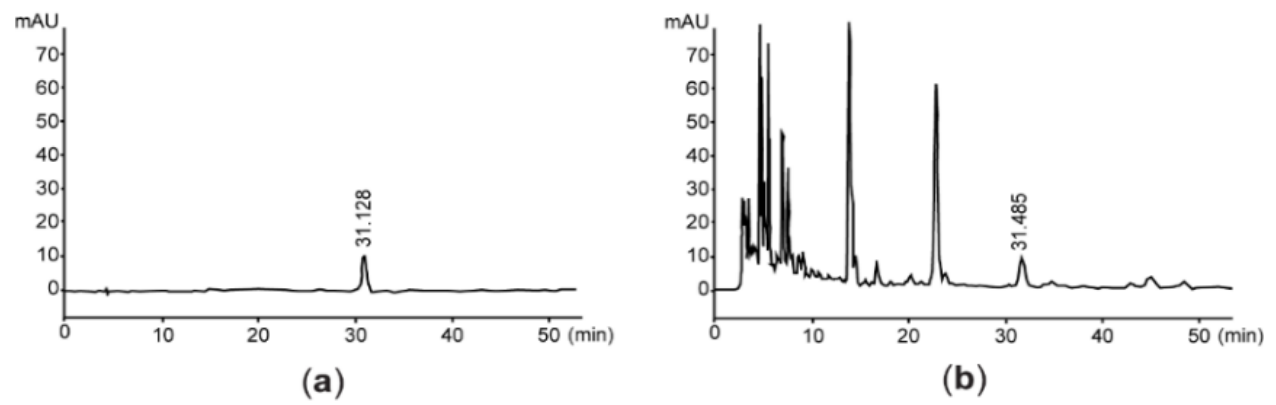
Figure 1. Representative HPLC chromatogram. Eluants are monitored at 254 nm after loading va- nillic acid 4- β -D-glucopyranoside ( a ) or AsE ( b ). The number in each chromatogram is the retention time. AsE, Adenophora stricta root extract; HPLC, high-performance liquid chromatography.